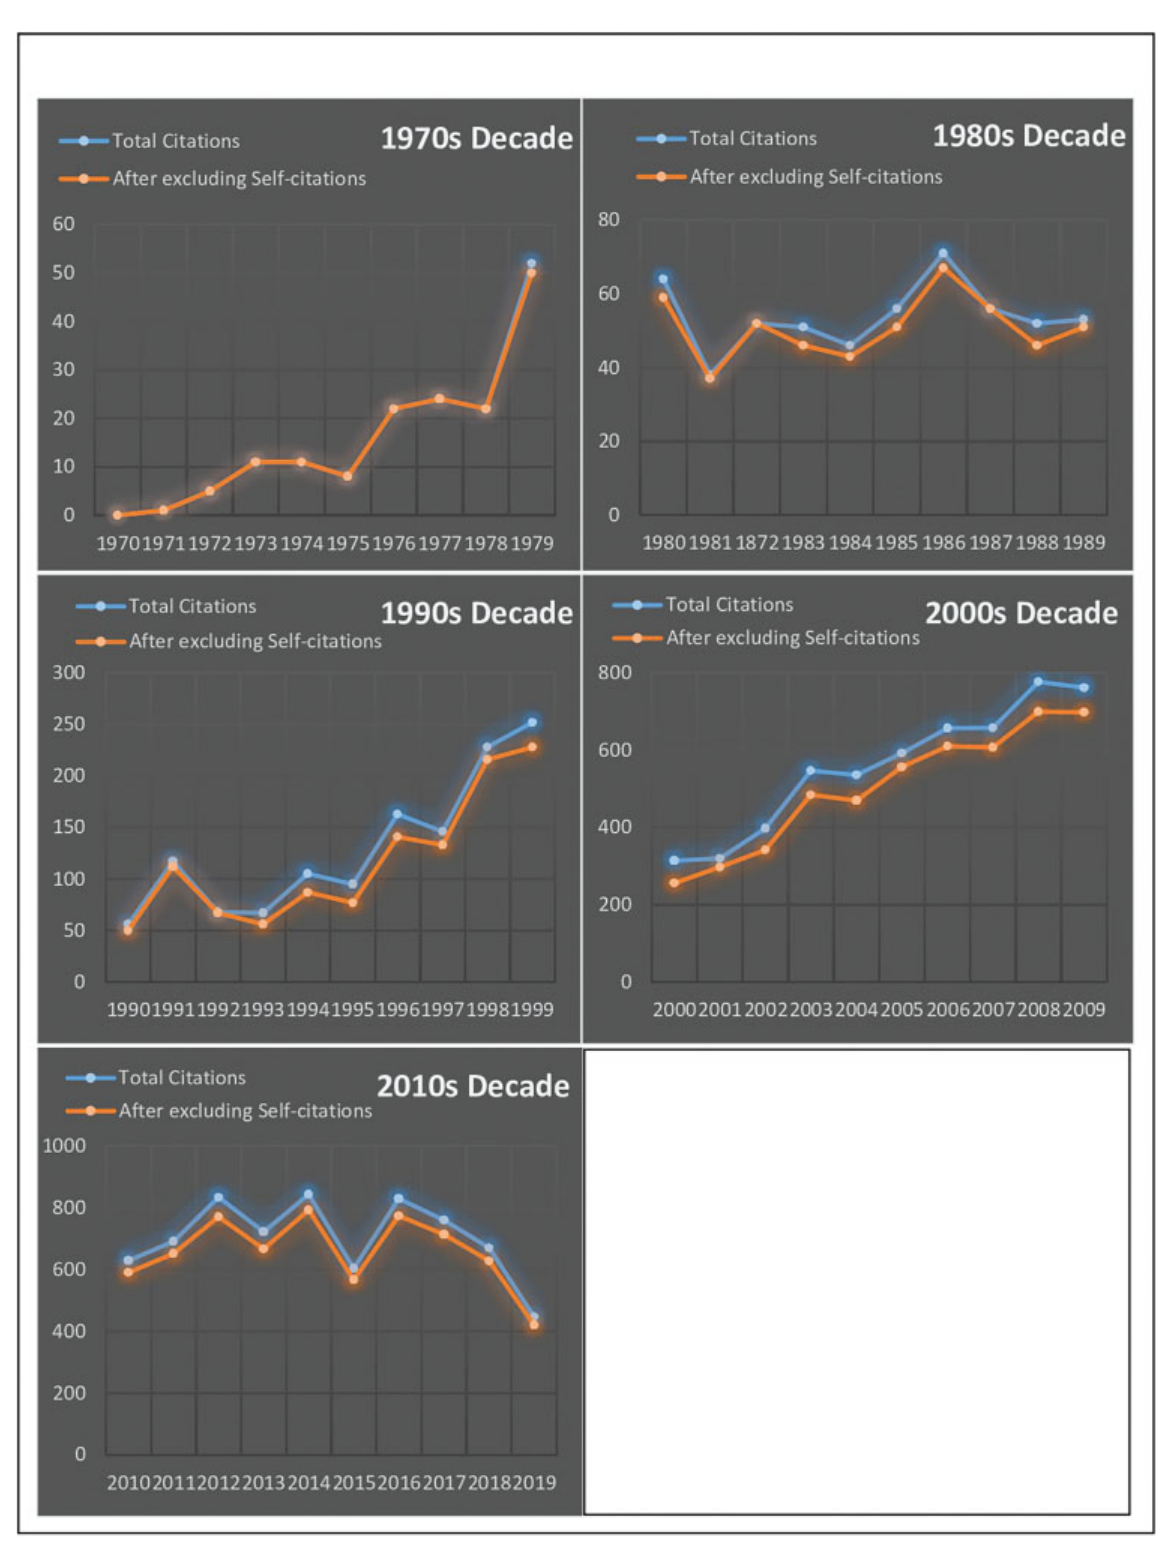
Fig. 2 Graphical presentation of rise or decline in citation frequency through decades and difference between total number of citation and number of citations after excluding